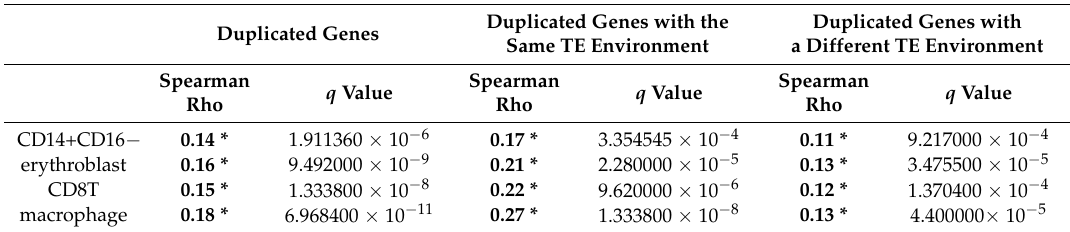
Table 4. Correlations of the methylation level between duplicated